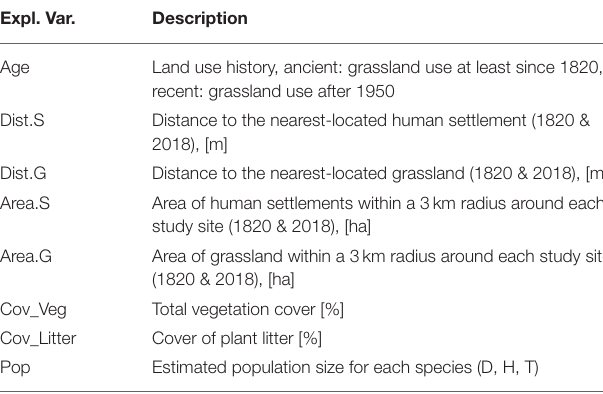
TABLE 1 | List of the explanatory variables included in the linear regression models. Expl. Var.